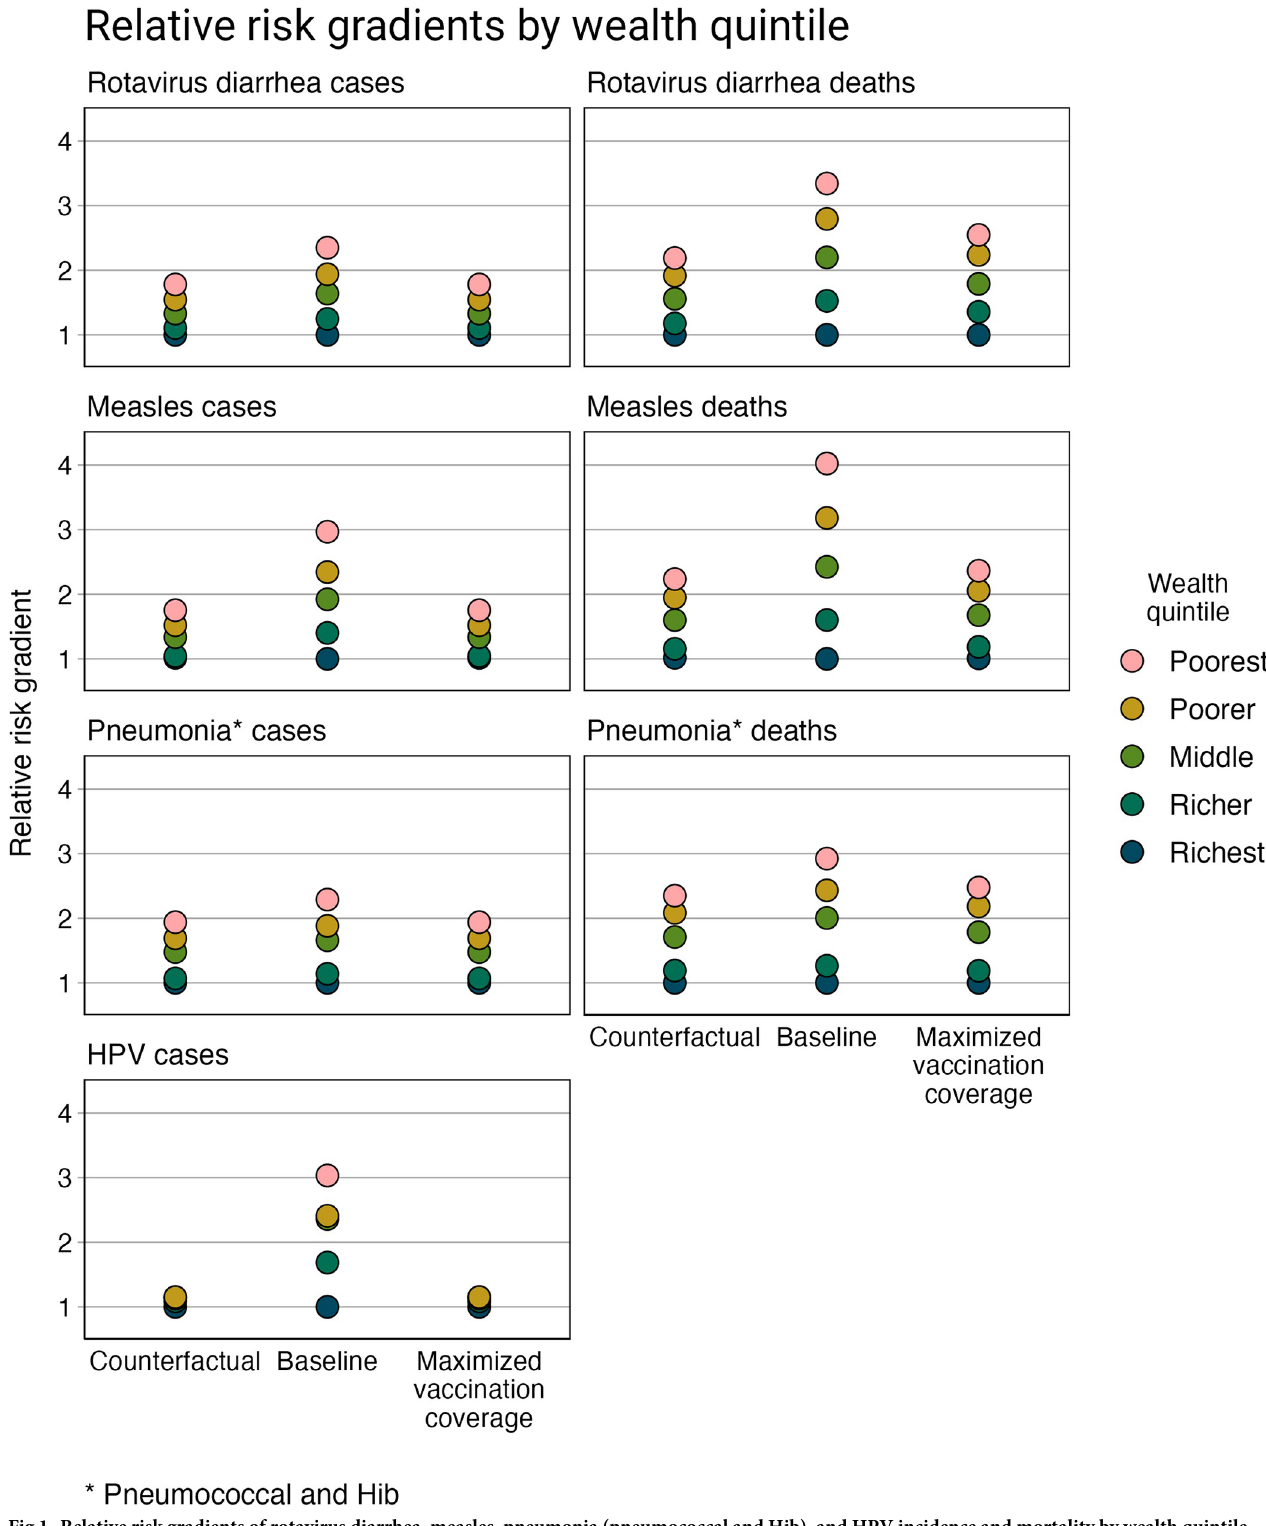
Fig 1. Relative risk gradients of rotavirus diarrhea, measles, pneumonia (pneumococcal and Hib), and HPV incidence and mortality by wealth quintile. The models for all three scenarios include the distribution of risk and prognostic factors. The “counterfactual” scenario presents a scenario without vaccination or treatment-seeking behavior; the baseline scenario presents a scenario with current vaccination coverage and treatment-seeking behavior; and the maximized